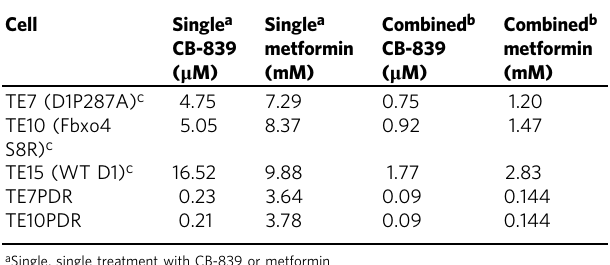
Table 1 The EC50s of listed compounds with either single or combined